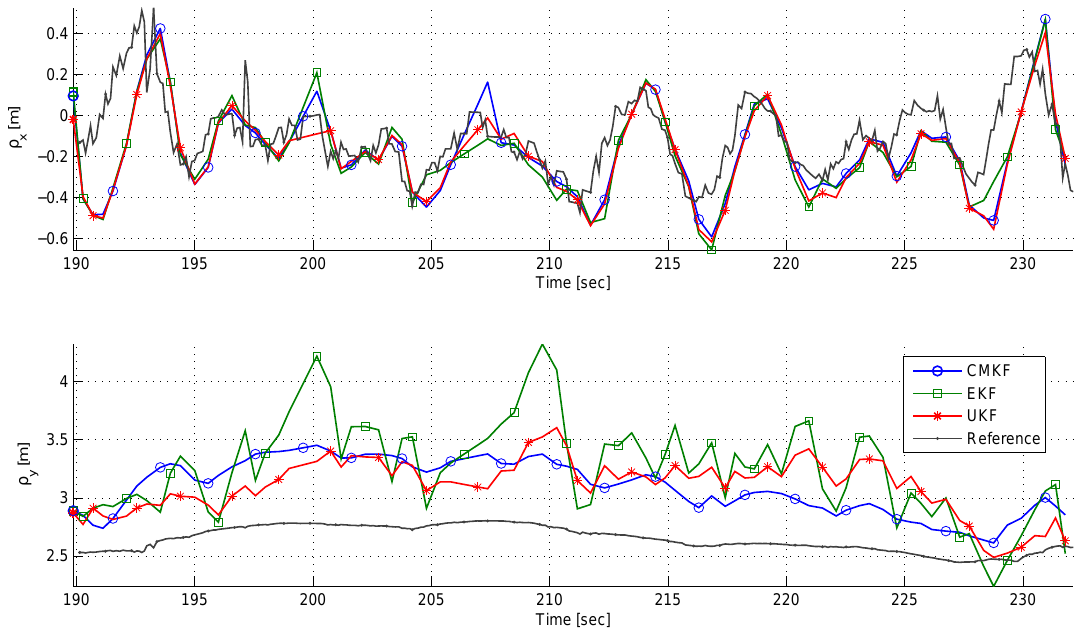
Figure 20. A comparison of ρ x ( top ) and ρ y ( bottom ) estimation using different filters in the dynamic experiment.